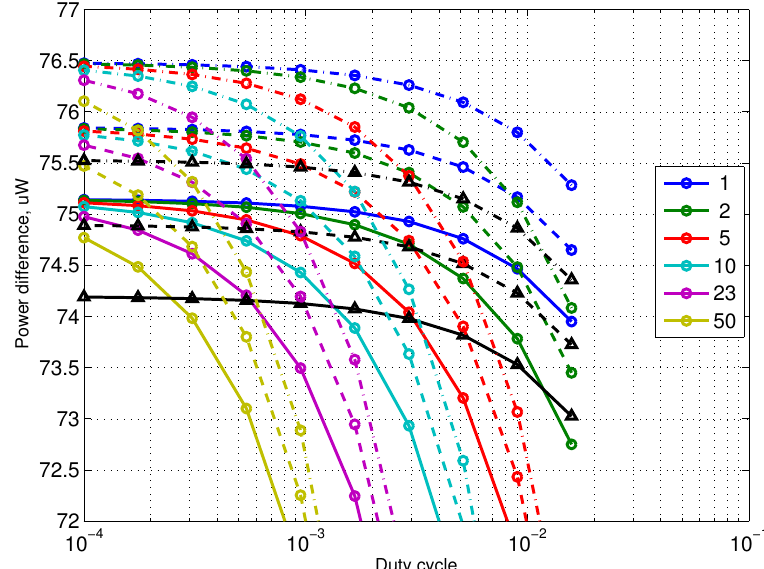
Figure 20. Detailed figure when M t = 1 and M r = 2, power difference while operating. Capacitor ( C s = 0.35 F). Non-WuR in black (without triangles), passive WuR in colors indicating number of nodes for different host duty cycles per node ( β (cid:48) w ). Semi-passive WuR in black with triangles. Line type indicates used SC leakage current model as —: upper , - - -: median, and -.-.-: